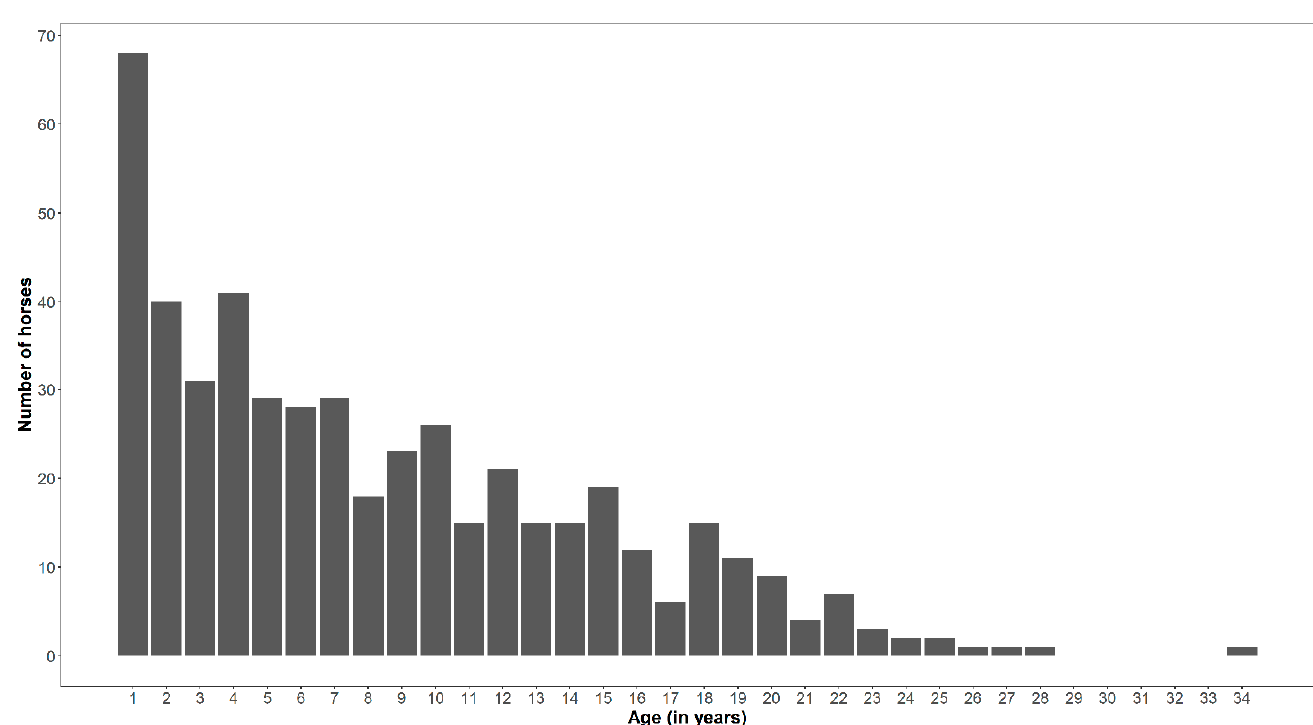
Figure 1. Distribution of the 493 sampled Rhenish German Draught horses by age in years including foals below one year old (category = 1) and up to a 33 years old horse (category = 34).